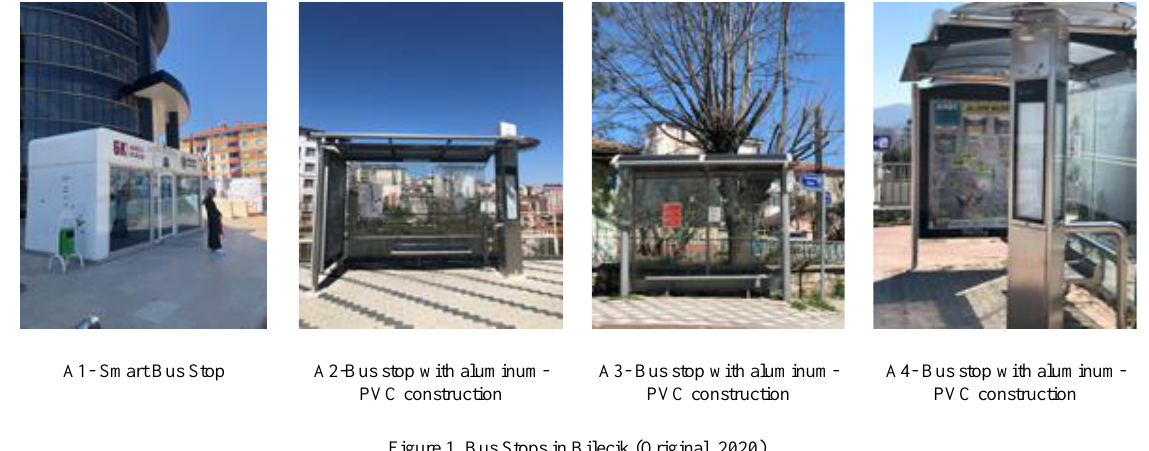
Figure 1. Bus Stops in Bilecik (Original,